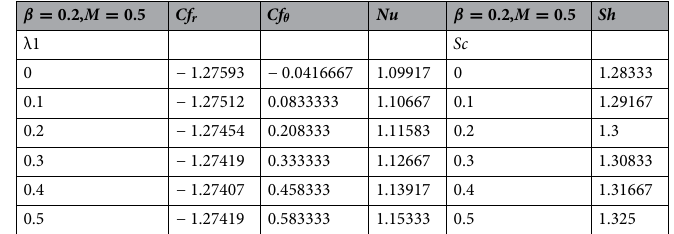
Table 2. Skin friction along the radial and tangential direction, Nusselt and Sherwood number for some values of the parameter (cid:31) 1 , the Schmidt number Sc .